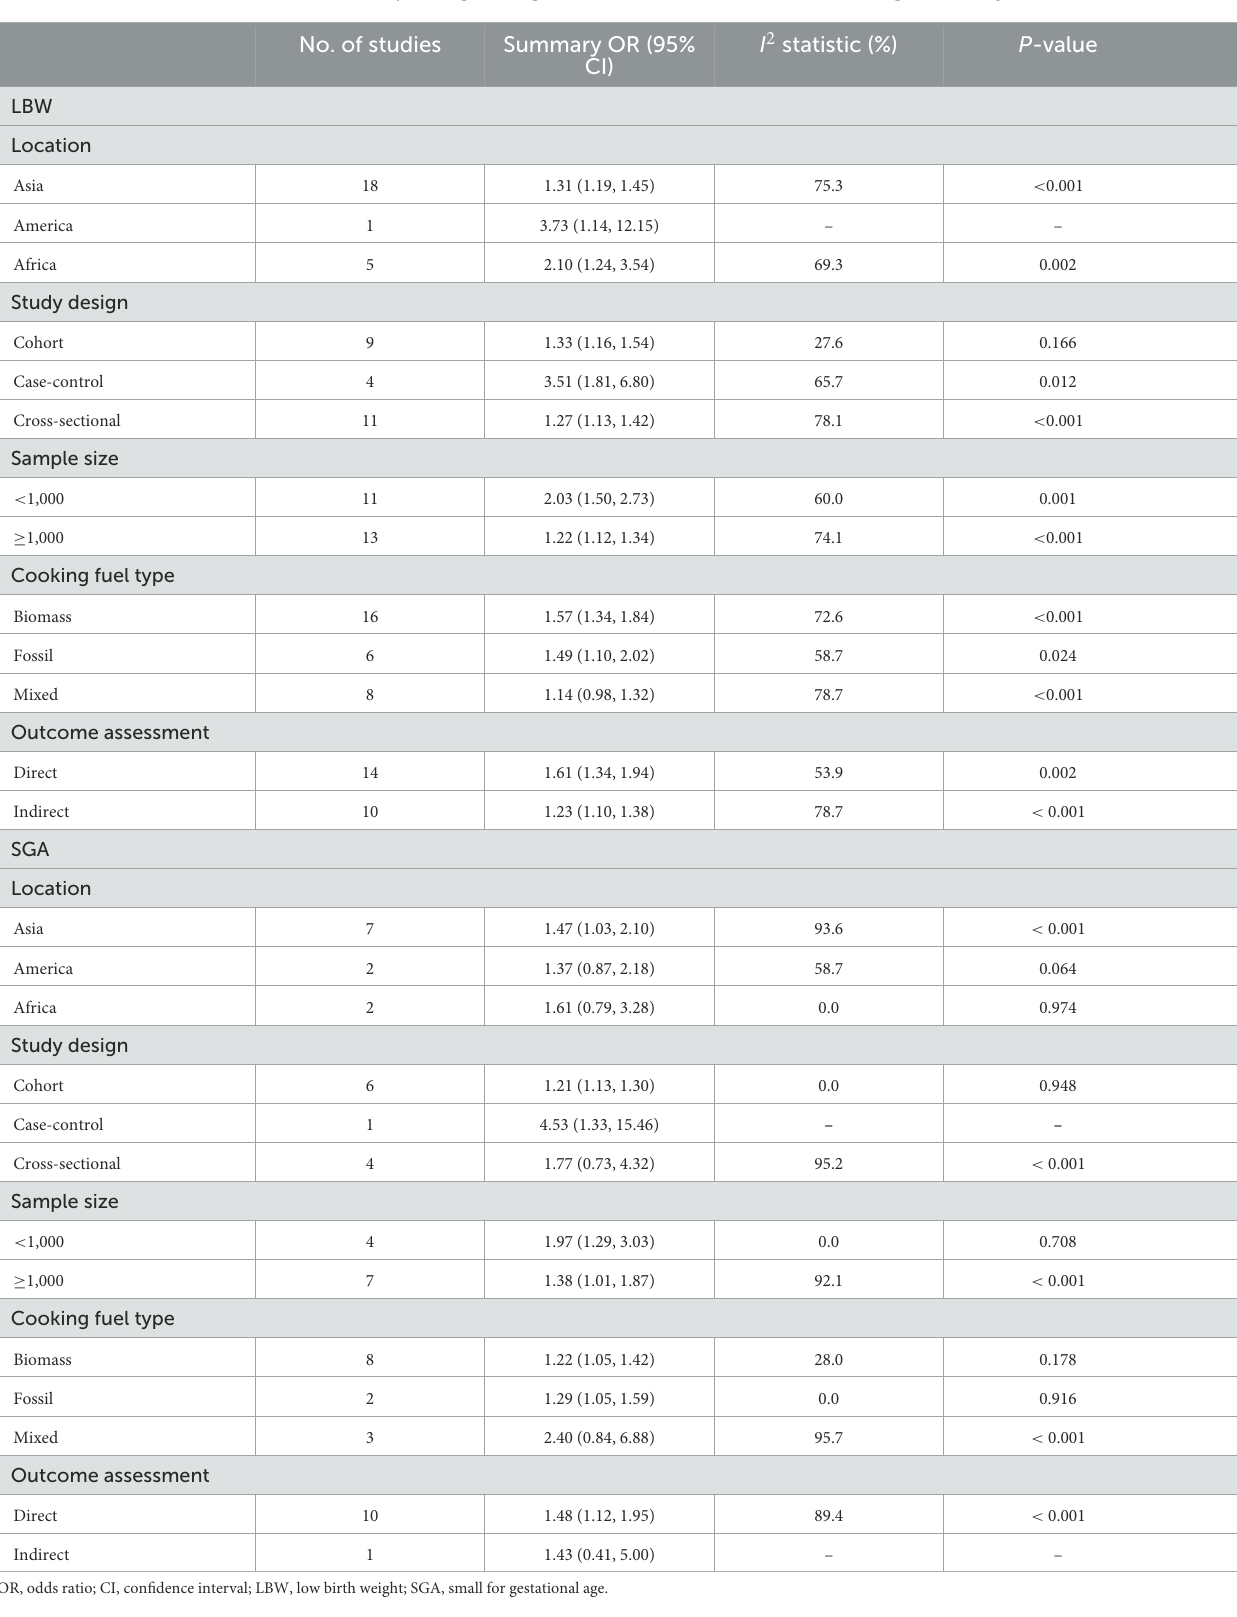
TABLE 2 Pooled estimates for the association of polluting cooking fuels with LBW and SGA stratified according to the study characteristics. No. of